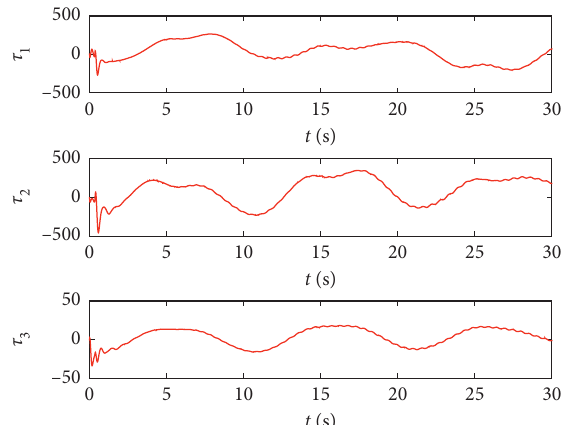
Figure 13: Control input under FTDO-ISMC.